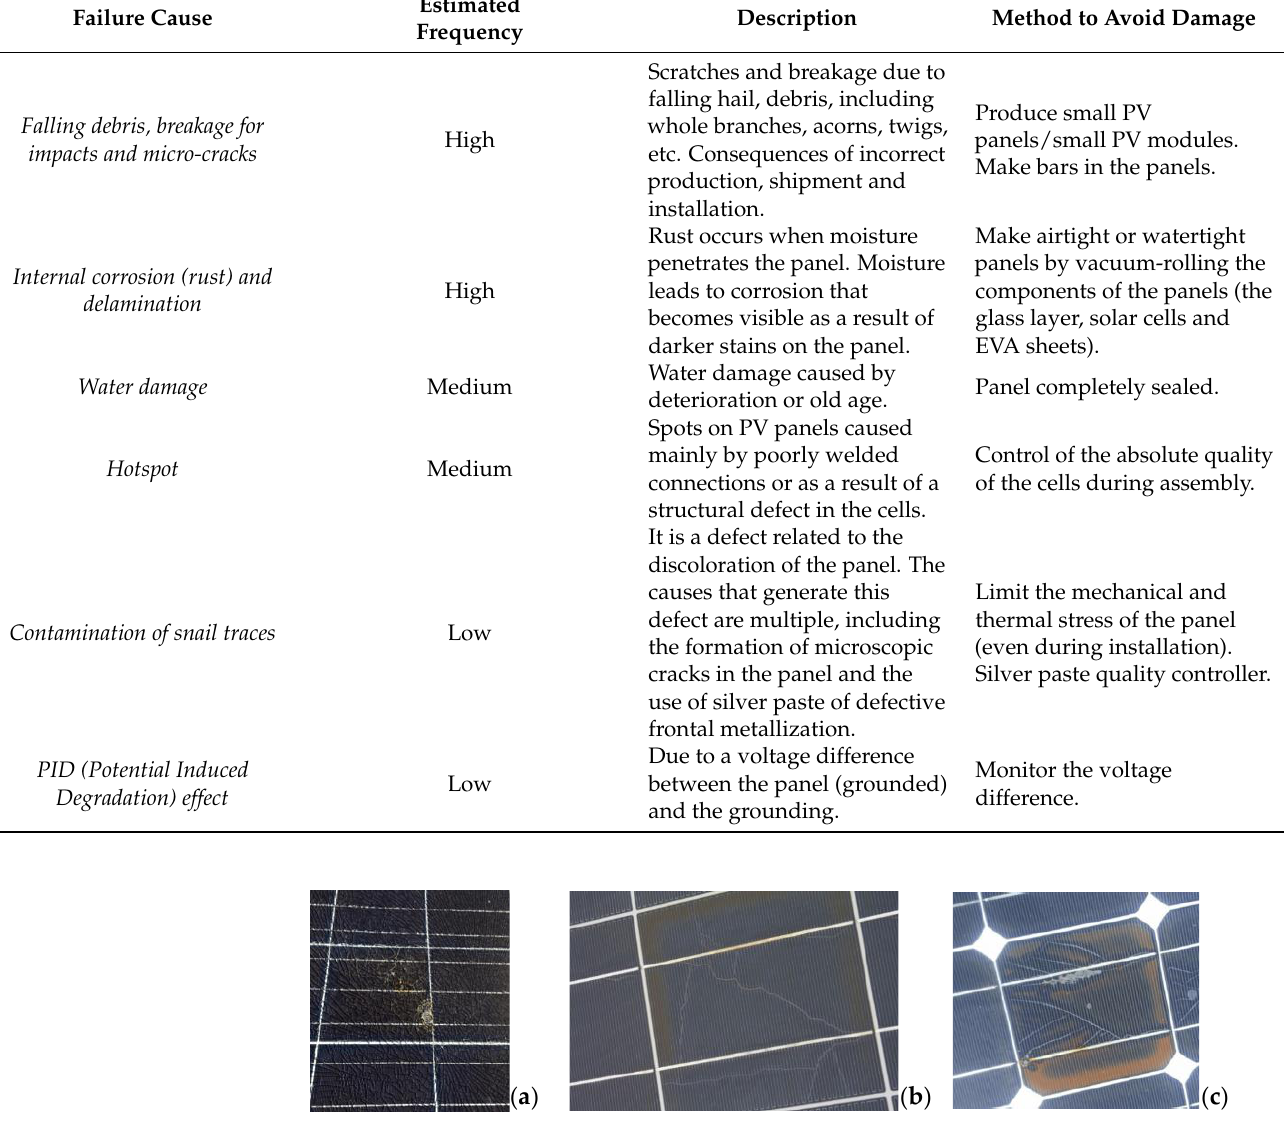
Table 7. Damage/failure causes in PV panels.